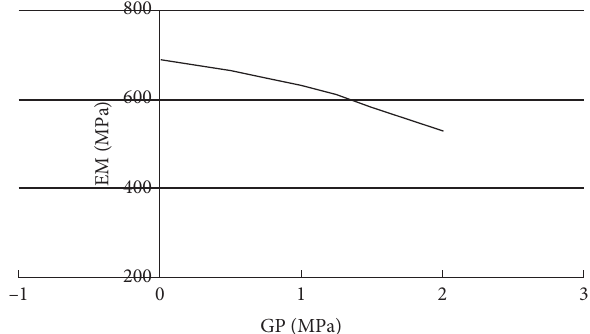
Figure 18: Variation in elastic modulus with changing gas